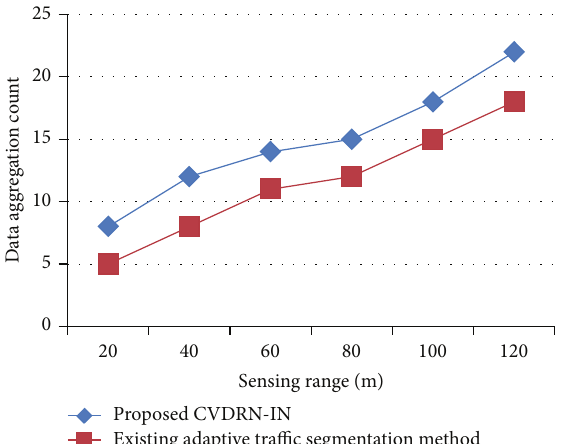
Figure 6: Measure of data aggregation count.